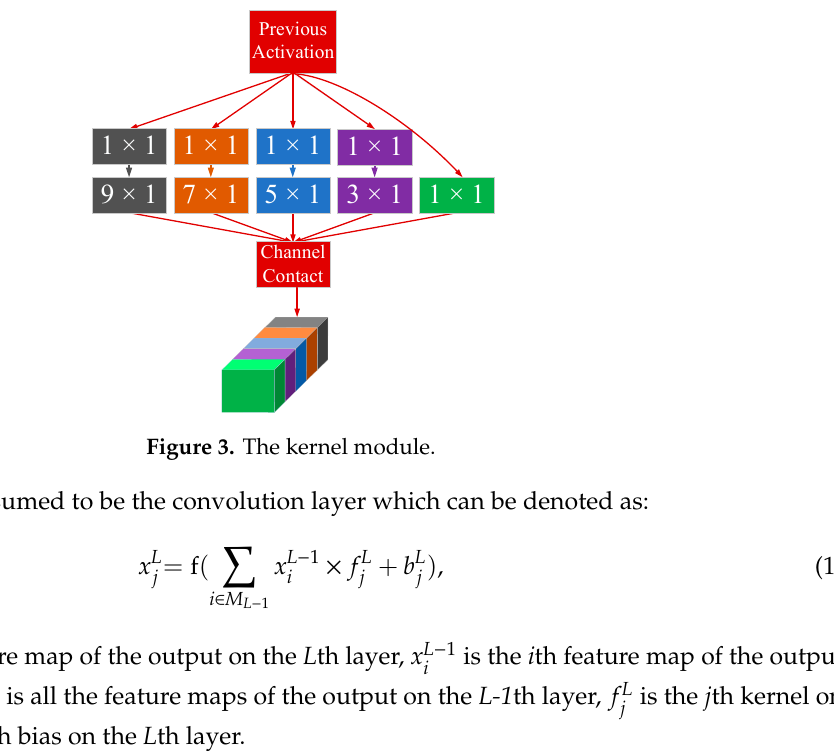
Figure 3. The kernel module.